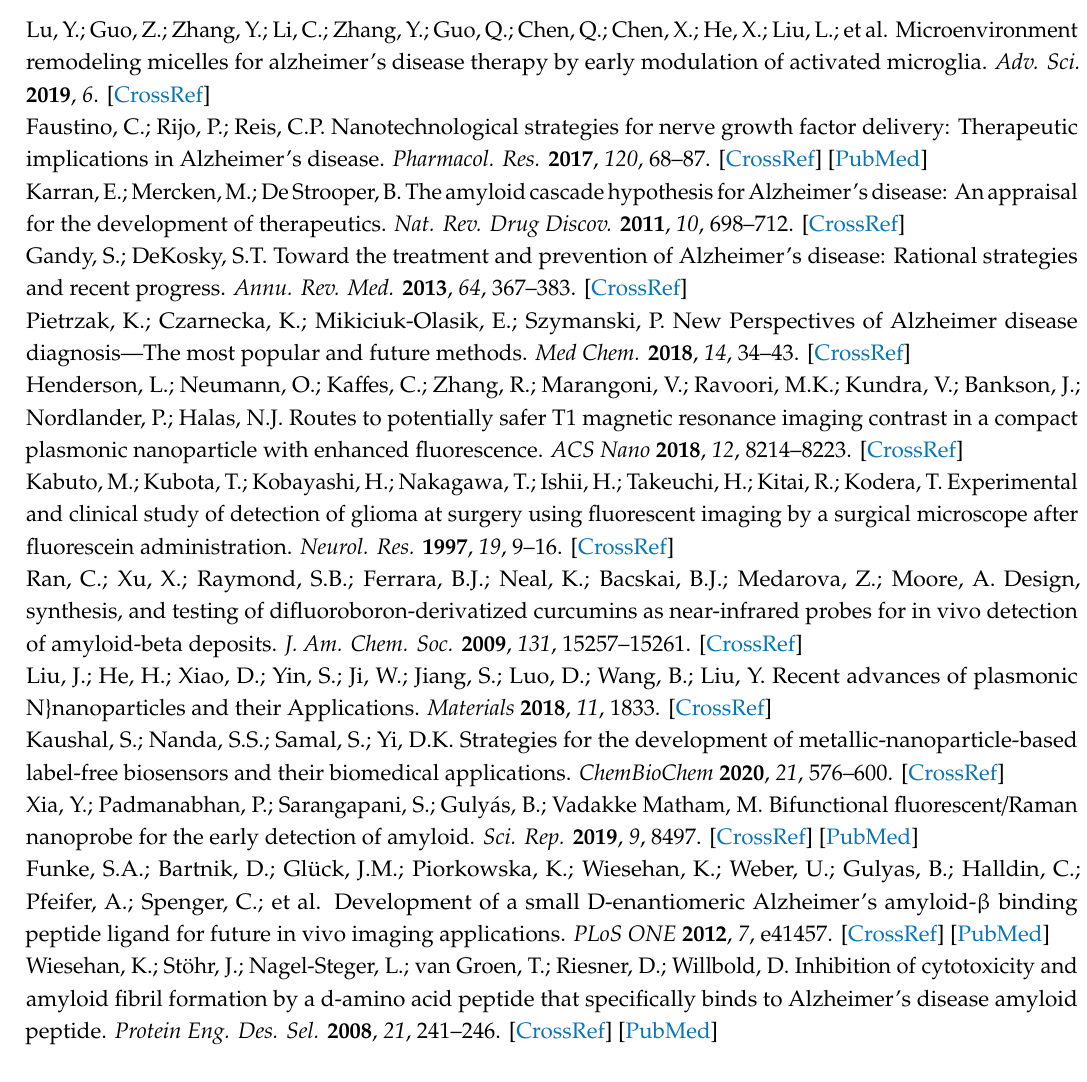
signal of CRANAD-2. Figure S7. Incubation of tissues with CRANAD-2 and GNR-PEG do not show significant di ff erences with respect to the control. Figure S9. Electrospray ionization (ESI)-MS spectrum of Curcuminoid. Figure S10. 1 H-NMR spectrum of CRANAD-2 in DMSO-d 6 . Figure S11. Electrospray ionization (ESI)-MS spectrum of CRANAD-2. The sample was dissolved in acetonitrile (equipment LCMS-2020). Figure S12. UV-vis absorption spectrum of curcuminoid (red) and CRANAD-2 (black), in CHCl 3 at 1 x 10 -5 M. Figure S13. Fluorescent emission spectrum of curcuminoid (red) and CRANAD-2 (black) in CHCl 3 at 1 × 10 − 5 M with 1% of